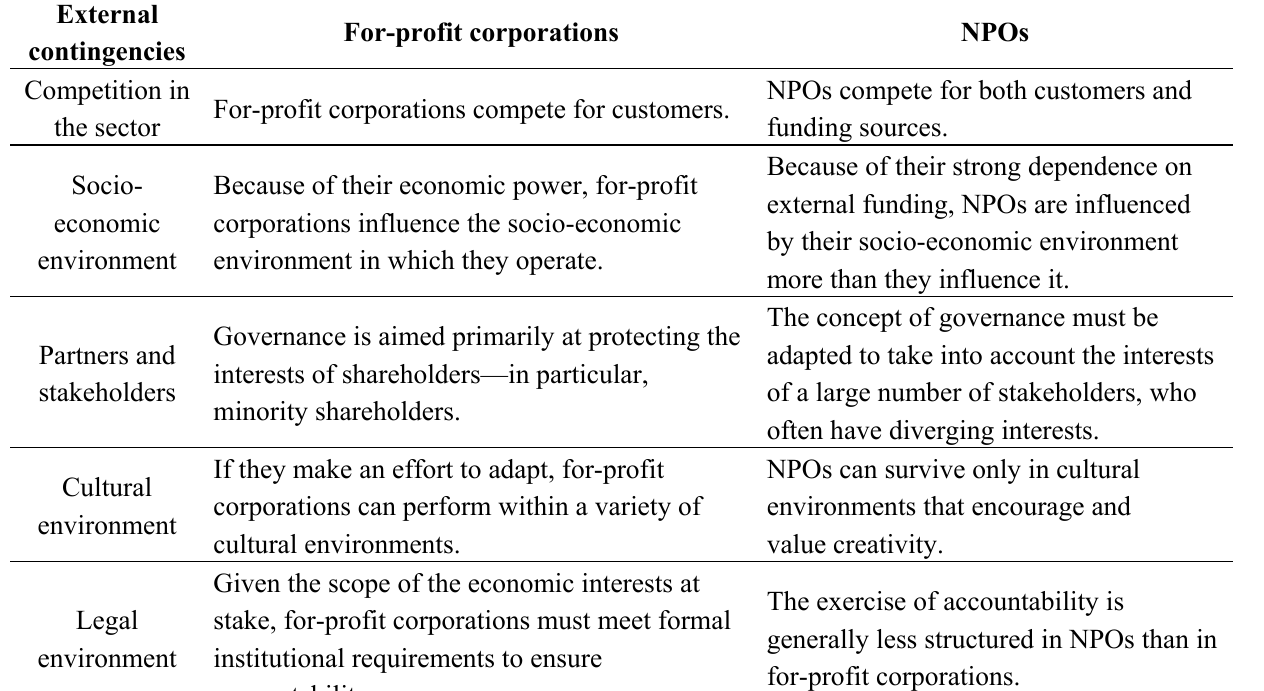
Table 1. Comparison of governance in for-profit corporations and